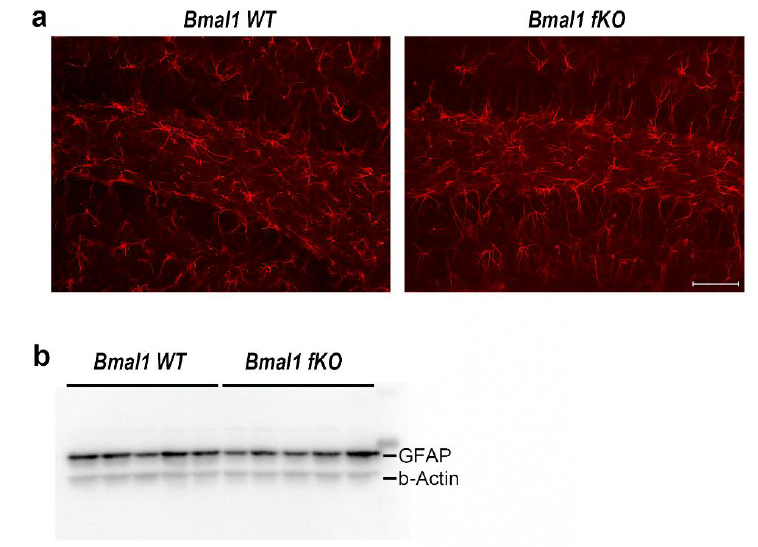
Figure 2. Astrocyte activation in the hippocampus of Bmal1 fKO mice. ( a ) Representative immunofluorescence of the astrocytic marker glial fibrillary acidic protein (GFAP) in the dentate gyrus of Bmal1 WT and Bmal1 fKO mice. Scale bar = 50 µ m. ( b ) Immunoblot of GFAP in hippocampus lysates of Bmal1 WT and Bmal1 fKO mice, n = 5 mice per